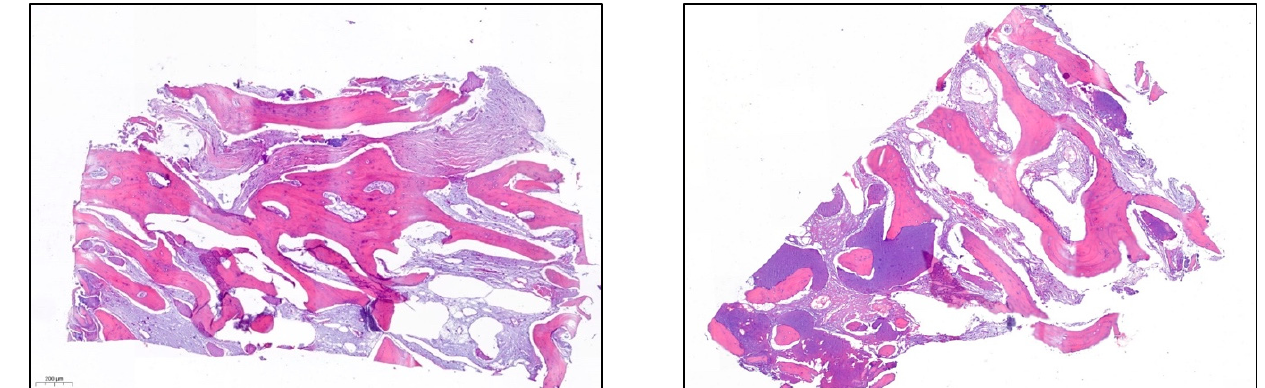
Figure 12. A well-formed and mature bone structure is observed.